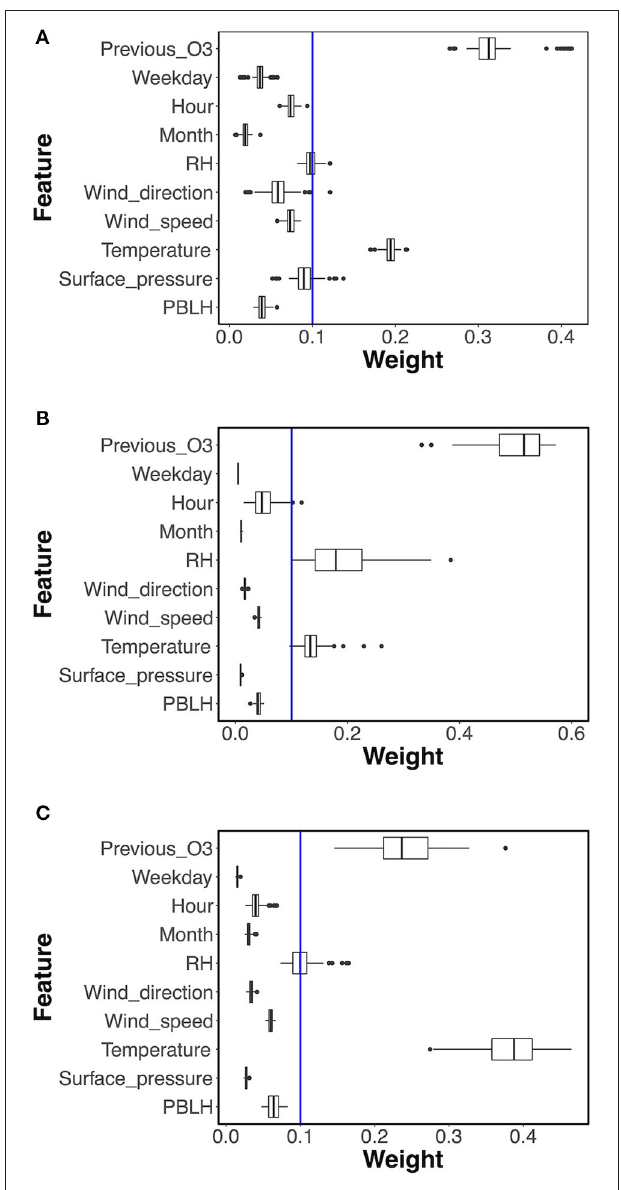
FIGURE 3 | Boxplot of feature weights from (A) RF classifier model in ML1, (B) the first and (C) the second RF regression model in ML2. The blue lines show the mean of the feature weights